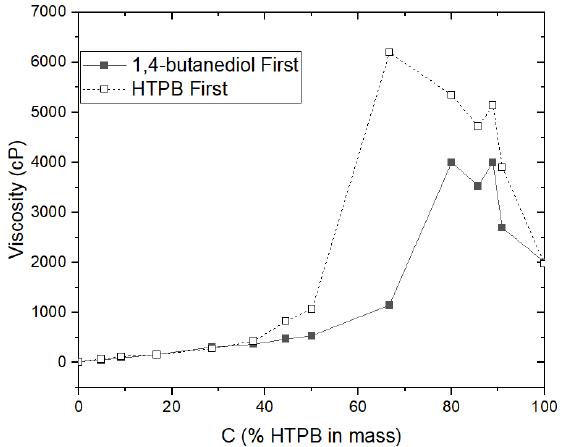
Figure 1. Viscosity profile of 1,4-butanediol and HTPB resin solutions, depending on the resin concentration, for both order of addition.